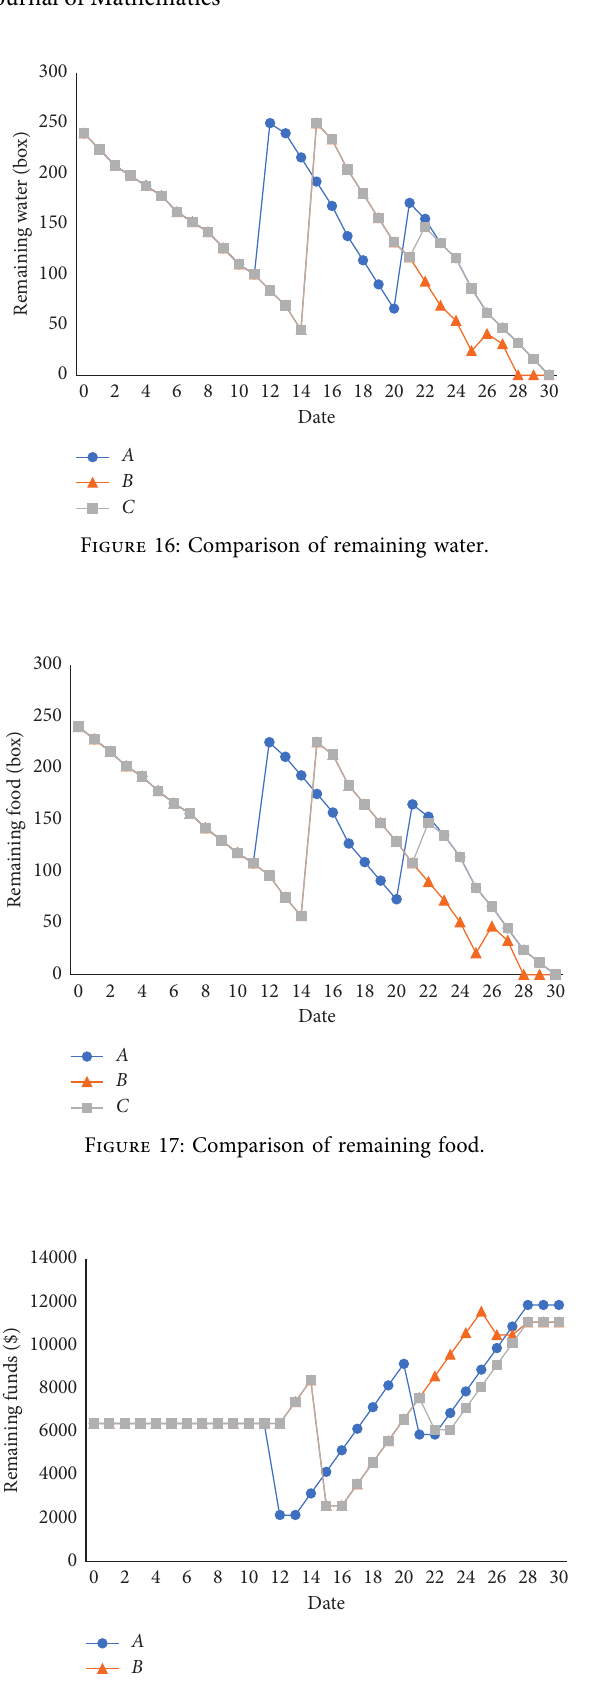
Figure 18: Comparison of remaining funds in Level 2.